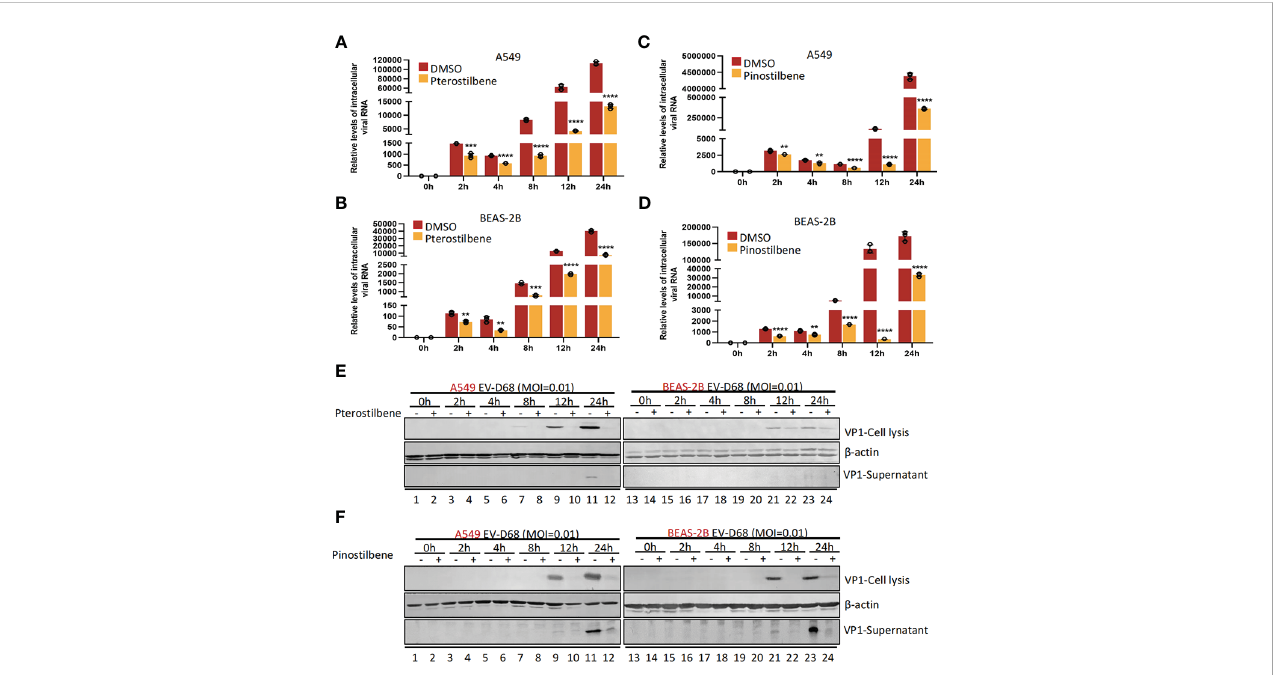
FIGURE 5 Pterostilbene (Pte) and pinostilbene (Pin) suppress EV-D68 RNA replication and VP1 synthesis post viral entry. A549 or BEAS-2B cells were pre-treated with Pte (25 µM), Pin (25 µM) or DMSO for 2 h and subsequently infected with EV-D68 at an MOI of 0.01. Cell or supernatant samples were collected at 0, 2, 4, 8, and 12 h post-infection. Relative intracellular viral RNA was detected using qRT-PCR (A – D) , Viral structural protein VP1 was measured by immunoblotting (E, F) . EV-D68, Enterovirus D68; DMSO, dimethyl sulfoxide; qRT-PCR, quantitative reverse transcription polymerase chain reaction; MOI, multiplicity of infection. Error bars indicate the standard deviation (**, P < 0.01; ***, P < 0.001; ****, P <